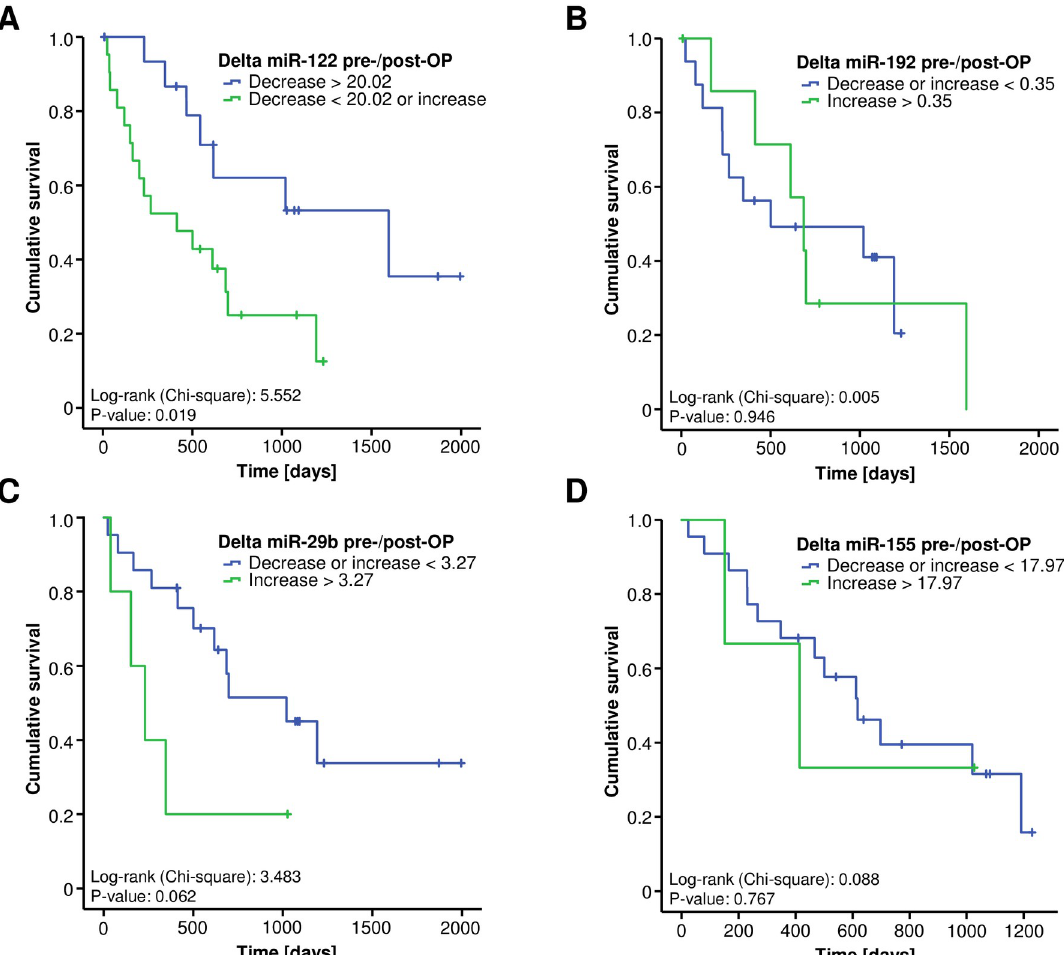
Fig 4. A strong post-operative decrease of miR-122 serum levels is associated with a good prognosis. Kaplan-Meier curve analysis shows that patients with a strong postoperative reduction of miR-122 have a significantly better median overall survival compared to patients with increasing or only slightly decreasing postoperative levels of miR-122 (A). A similar trend of a better prognosis after tumor resection can be found for a strong postoperative decrease of miR-29b (not significant, C), whereas longitudinal changes of serum miR-192 and miR-155 do not reflect patients’ prognosis (B and D).